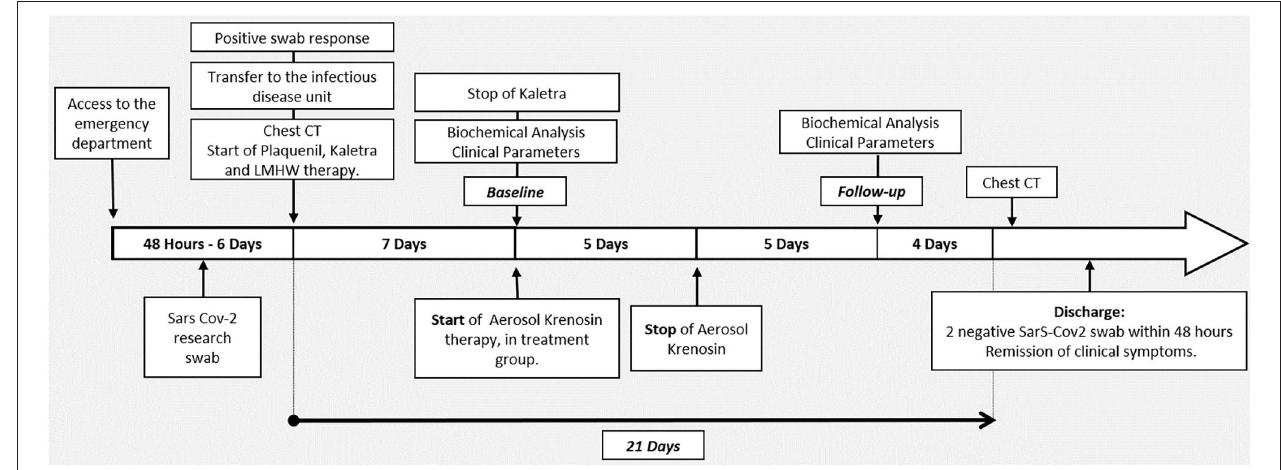
FIGURE 1 | Timeline of progress from admission to